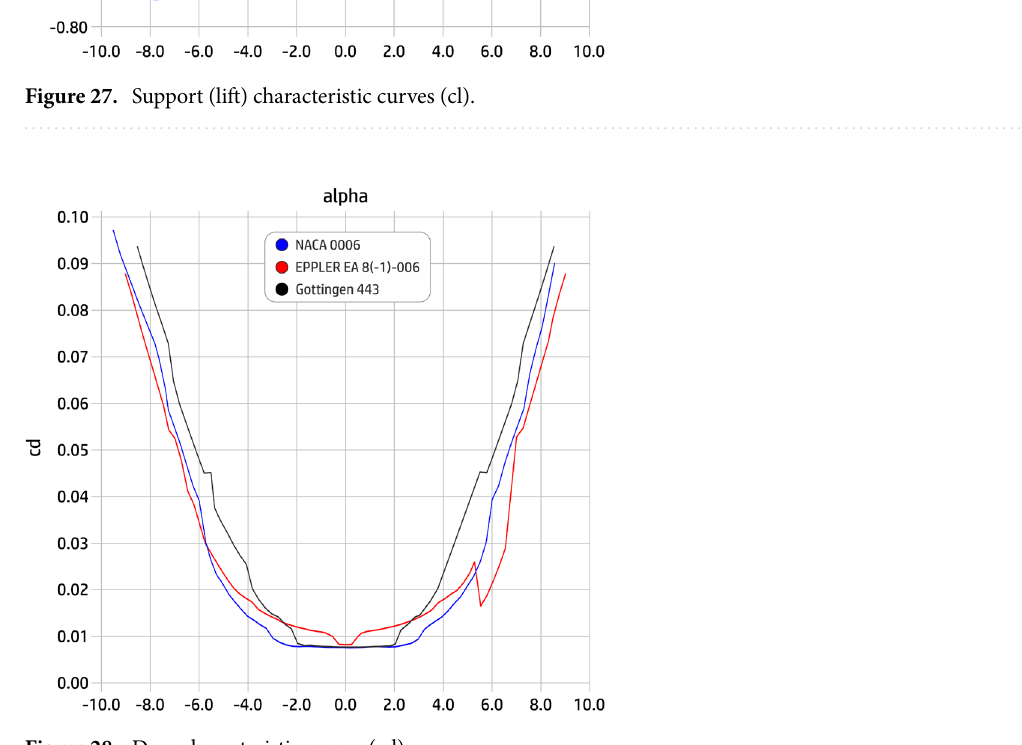
Figure 28. Drag characteristic curves